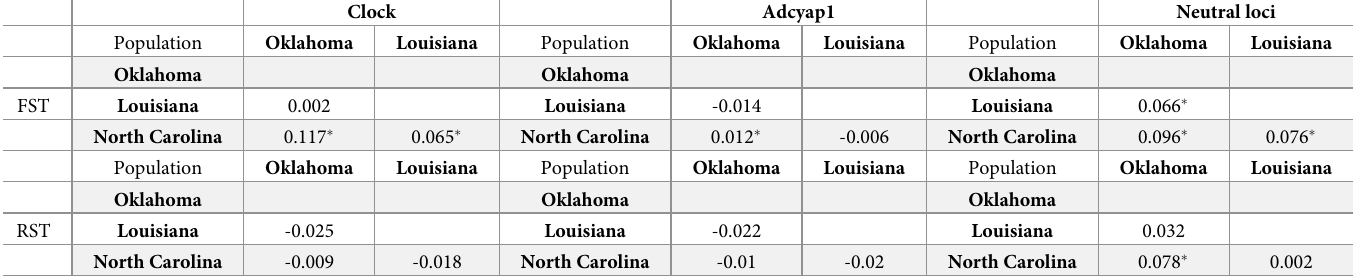
Table 2. FST and RST values. FST and RST values for population differentiation at Clock , Adcyap1 , and neutral loci computed in